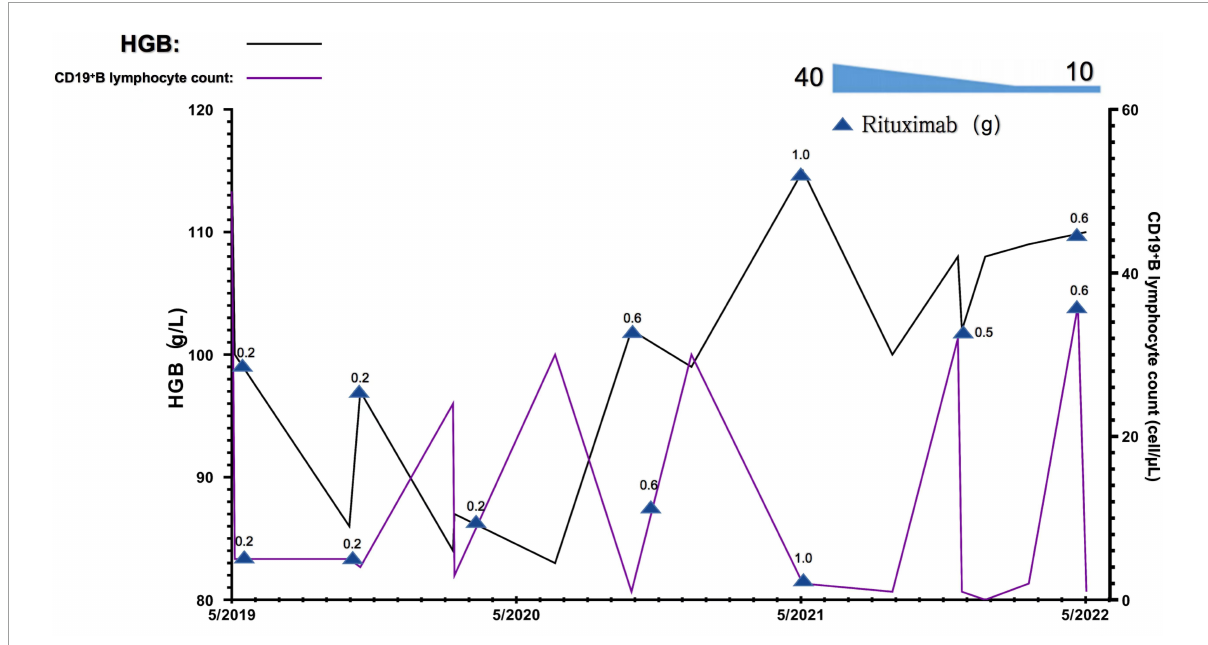
FIGURE4 Changes in blood hemoglobin (hgb) levels and CD19 + B lymphocyte counts of this patient during the observational period. 0.2, 0.5, 0.6, and 1.0 denote the dose of rituximab used at this timepoint g,